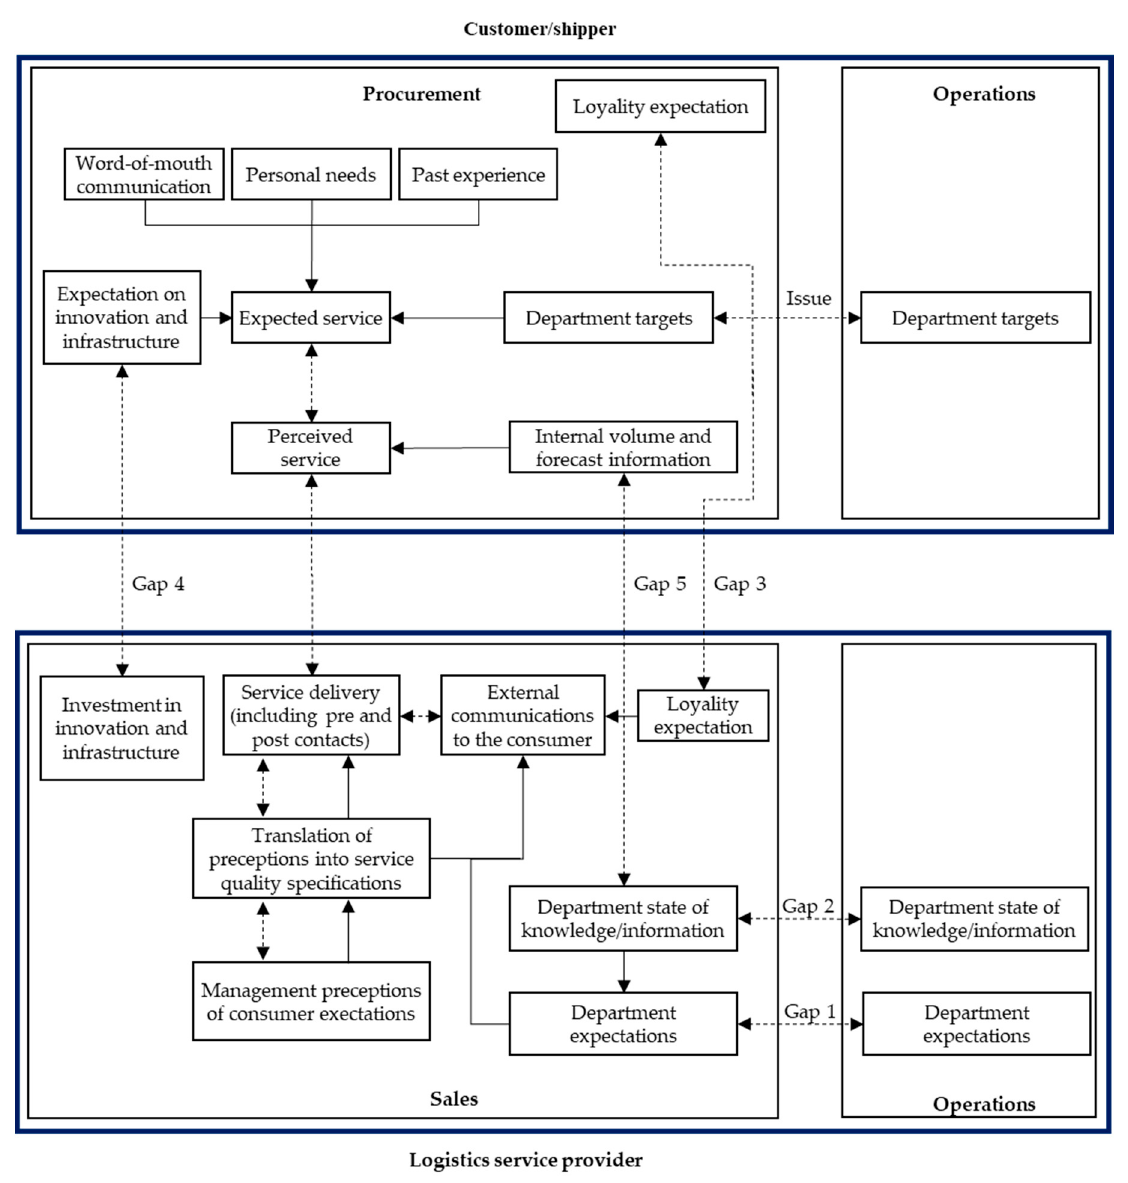
Figure 5. Multi-sided model of service quality for the logistics service industry.